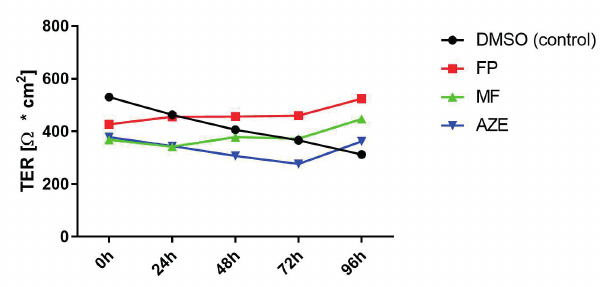
Figure 2. Shows the TER [Ω * cm2] at given time points before (T0) and